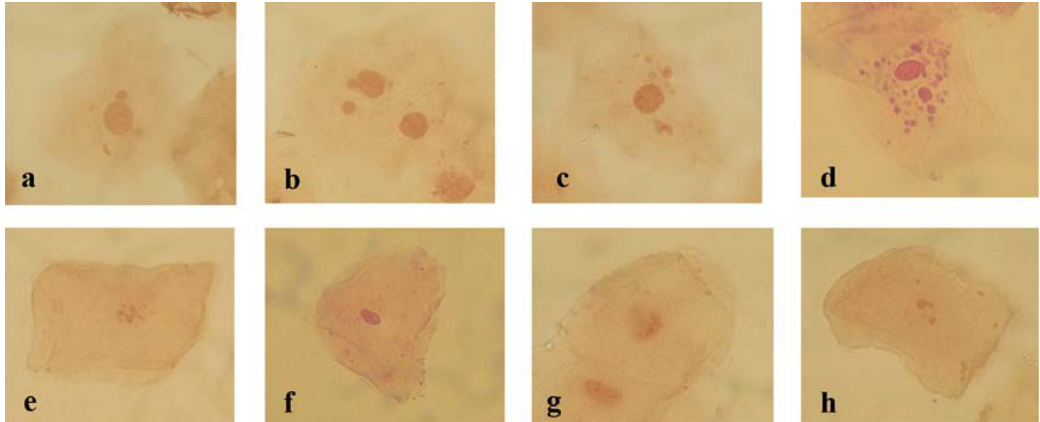
FIGURE 3. Photomicrographs of exfoliated buccal cells stained using acetorcein in the BMCyt assay; (a) differentiated cell with two micronuclei; (b) cell with a micronucleus and nuclear bud; (c) and (d) cells with more micronuclei; (e) karyorrhectic cell; (f) pycnotic cell; (g) karyolytic cell; (h) fragmented nucleus. All photos were taken at 1,000x magni fi